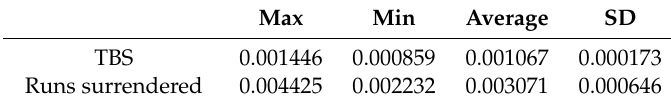
Table 2. Descriptive statistics of input-output indicators of CPBL teams’ defensive